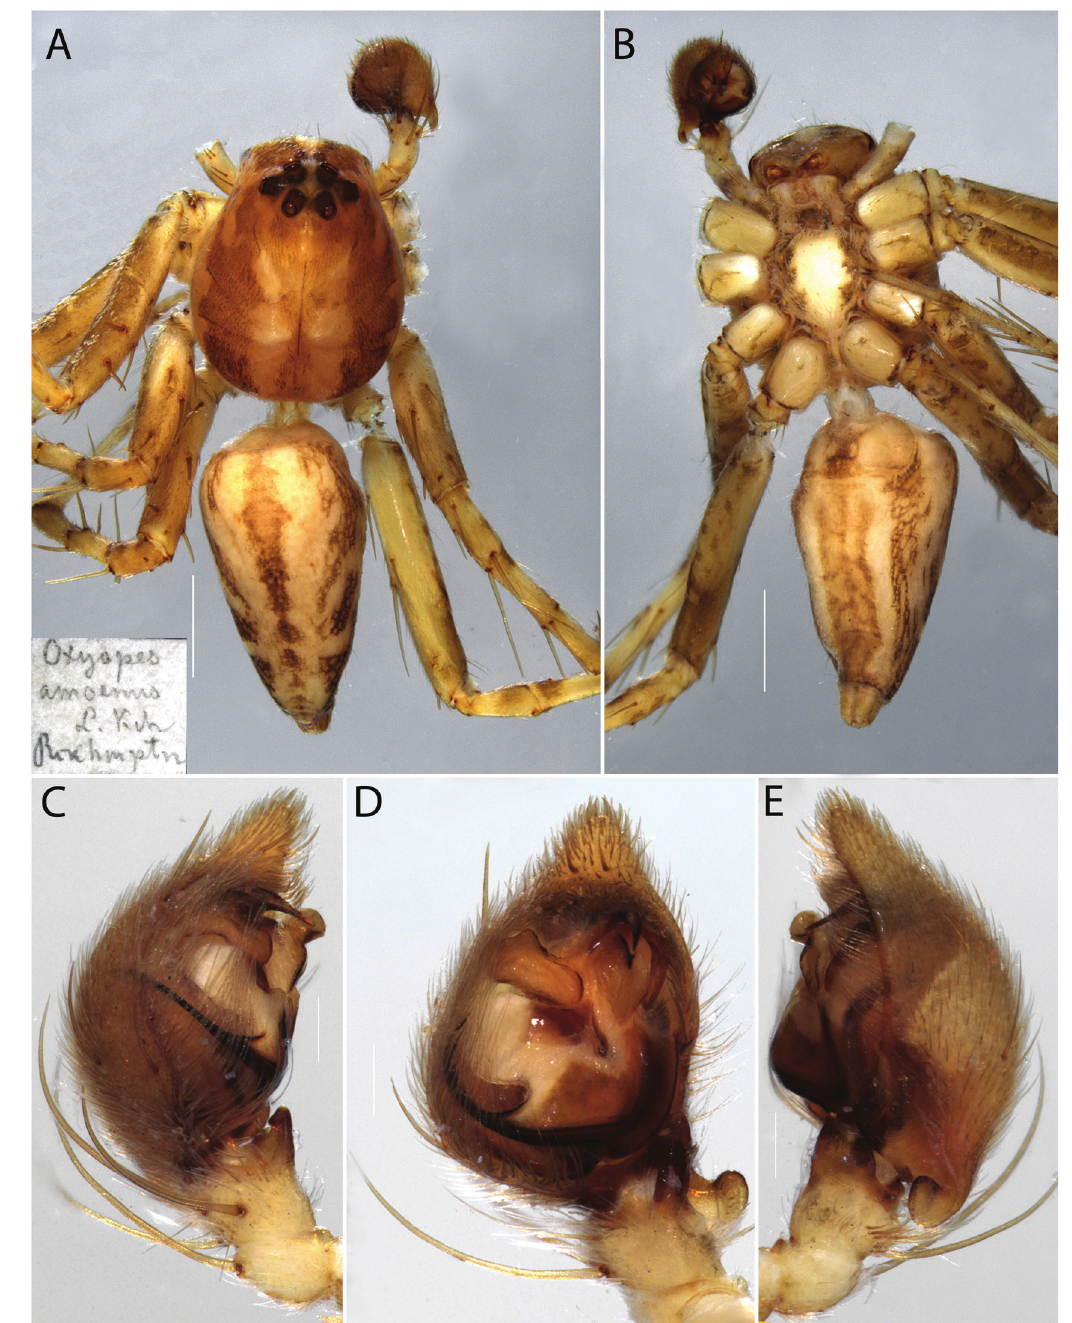
Figure 3. Oxyopes amoenus L. Koch, 1878, male lectotype (ZMH- A0000029): A , habitus, dorsal view; B , habitus, ventral view; C, male palp, prolateral view; D , same, ventral view; E , same, retrolateral view. Scale bars: habitus 1.0 mm, palp 0.1